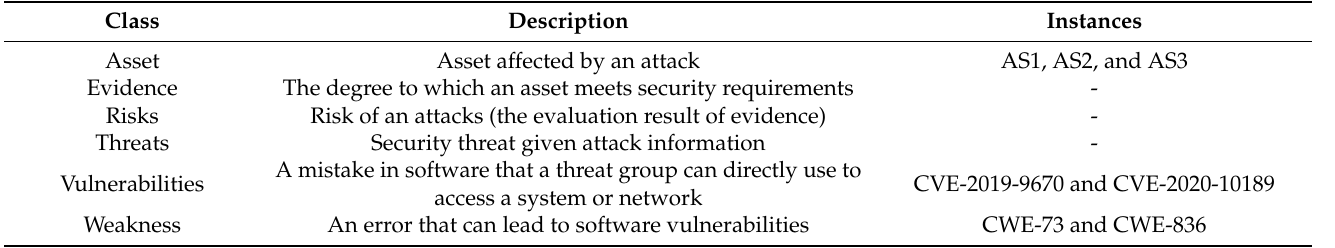
Table 2. Description of the risk component.